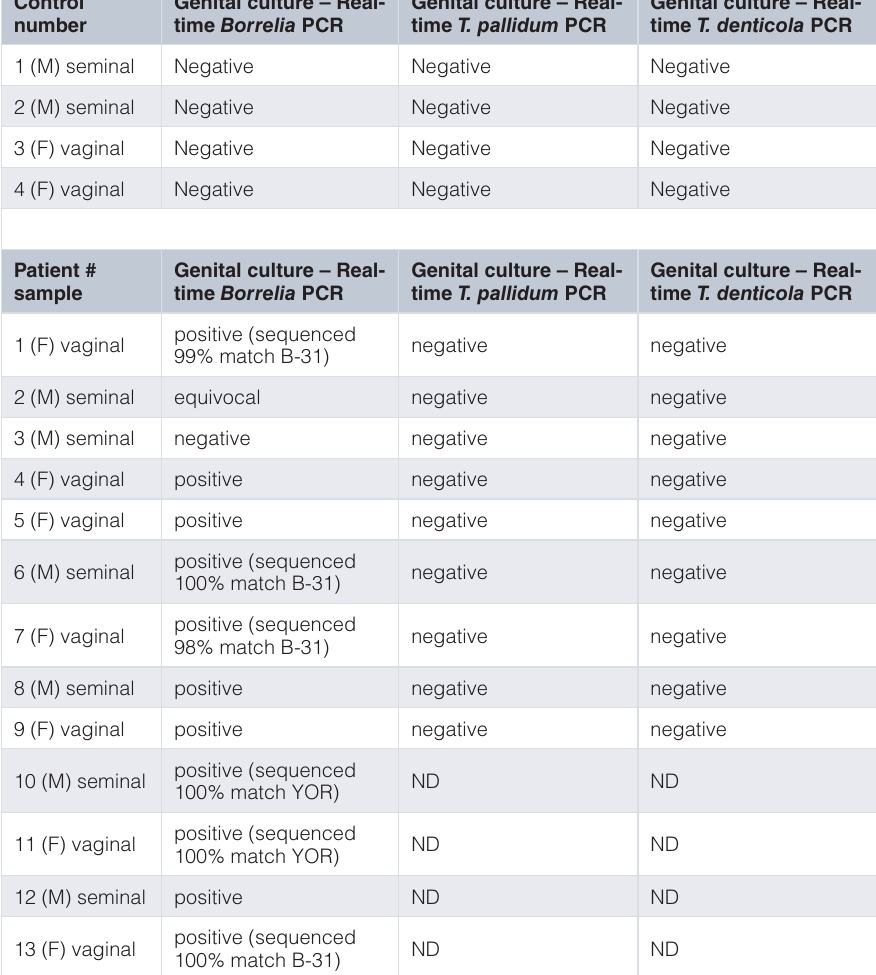
Table 5A: Real-time PCR – Australian